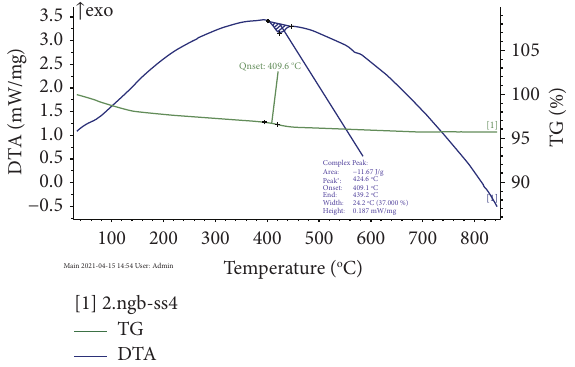
Figure 14: Mix 4 thermogravimetric analysis (TGA).